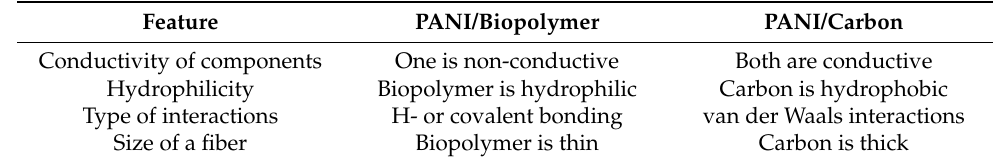
Table 5. Comparative features of PANI/biopolymer and PANI/carbon humidity sensors. Feature PANI/Biopolymer PANI/Carbon Conductivity of components One is non-conductive Both are conductive Hydrophilicity Biopolymer is hydrophilic Carbon is hydrophobic Type of interactions H- or covalent bonding van der Waals interactions Size of a fiber Biopolymer is thin Carbon is